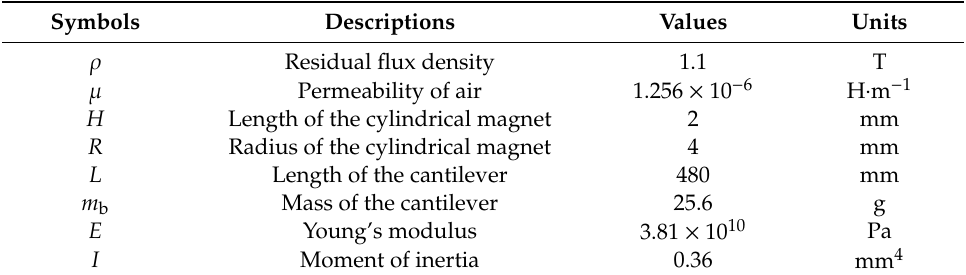
Figure 1. The electromechanical system for piezoelectric energy harvesting (PEH): ( a ) cantilevered structure; ( b ) electric circuit. Table 1. The structural parameters considered in this paper and